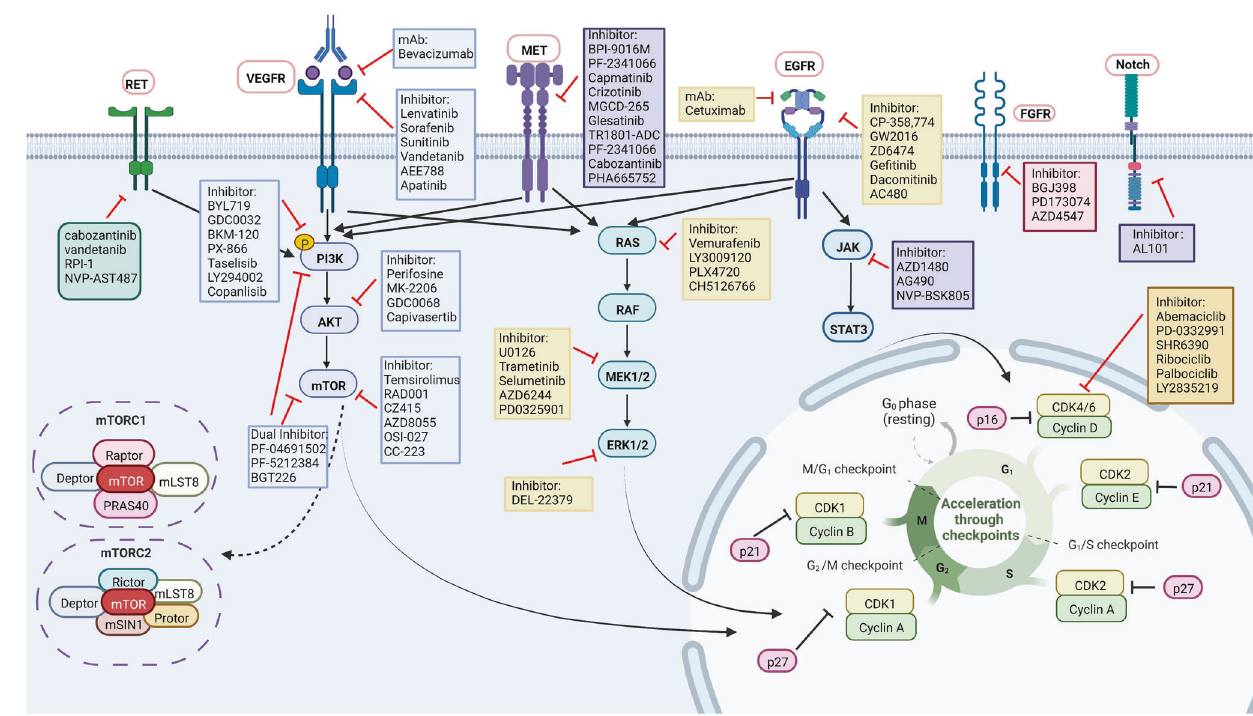
Fig. 5 Comprehensive understanding and inhibitor direction for targeting signaling pathways in preclinical HNC treatment. EGFR epidermal growth factor receptor, EGF epidermal augmentum factor, MET mesenchymal – epithelial transition factor, JAK Janus-activated kinase, STAT signal transducer and activator of transcription, AKT serine/threonine-speci fi c protein kinase, mTOR mammalian target of rapamycin, CDK cyclin-dependent kinase, VEGF vascular endothelial growth factor, mAb monoclonal antibody, RET rearranged during transfection,